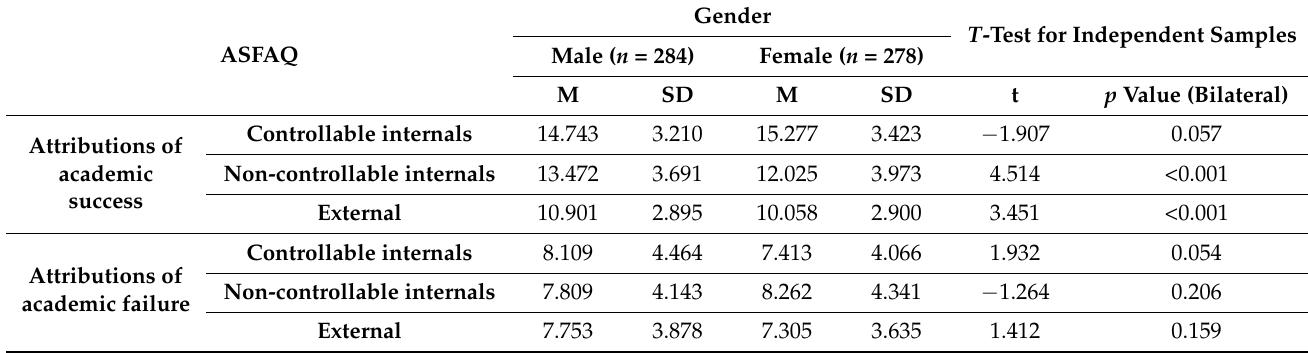
Table 5. Results of the t -test for independent samples between the ASFAQ and gender .